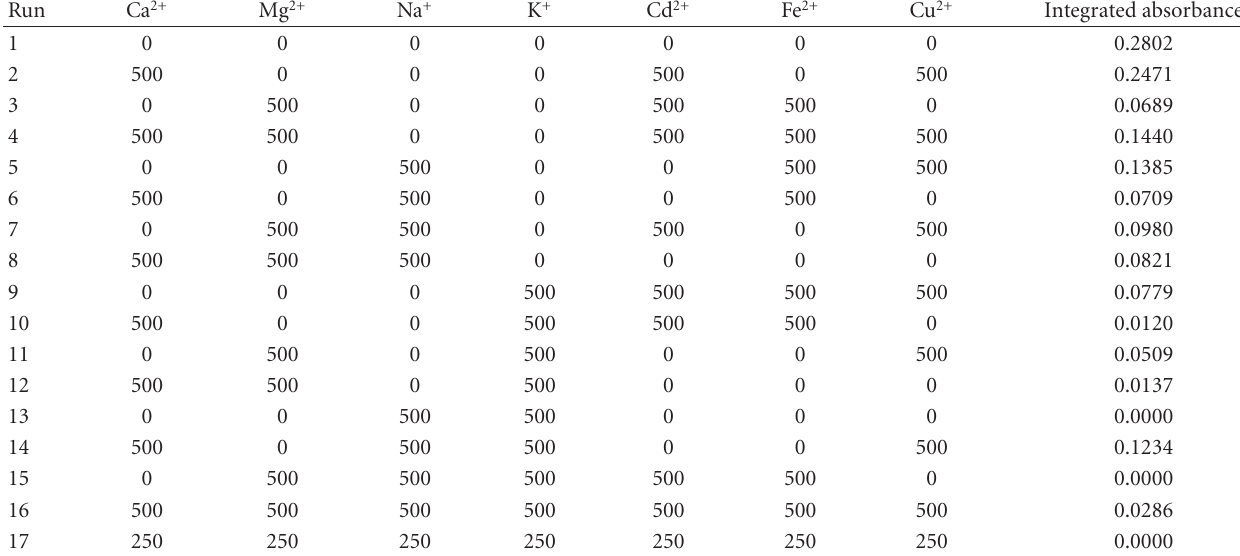
Table 2: Resulting matrix of the factorial design and analytical response ∗ .